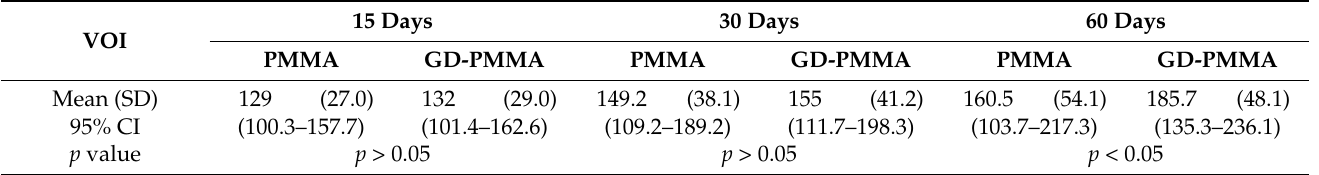
Table 4. Summary of histomorphometric micro-CT volume of interest (VOI) between the PMMA implants group and GD-PMMA implants group (Kruskal Wallis followed by the Bunn’s test).